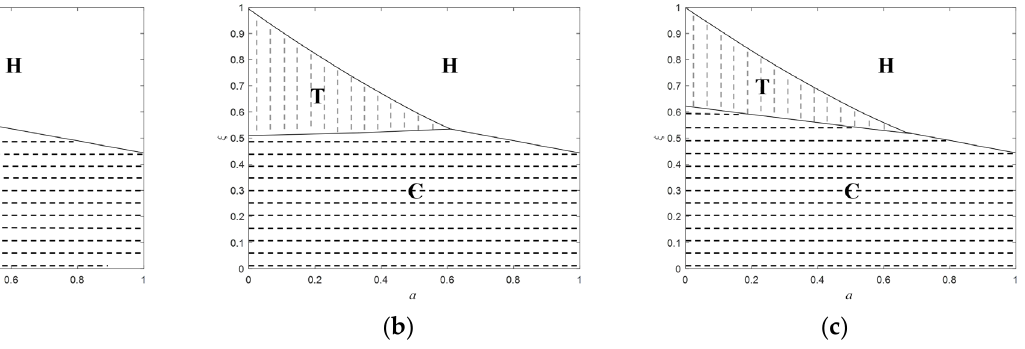
Figure 4. Return policy selection of brand under high commission rate. ( a ) δ = 0.6; ( b ) δ = 0.75; ( c ) δ =